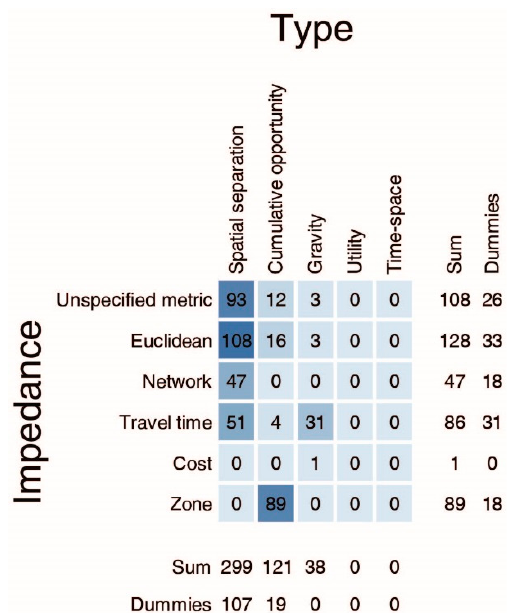
Figure 5. The frequency of the use of the specific combination of impedance and type in the reviewed sample of papers. The numbers in the figure represent the amount of times the combination opportunity-type is used; the darker blue, the more frequent this combination is used; the sum shows the total amount of times the impedance or type is used, irrespective of the other aspect. The list “Dummies” show how many times type and impedance variables actually are dummy variables.